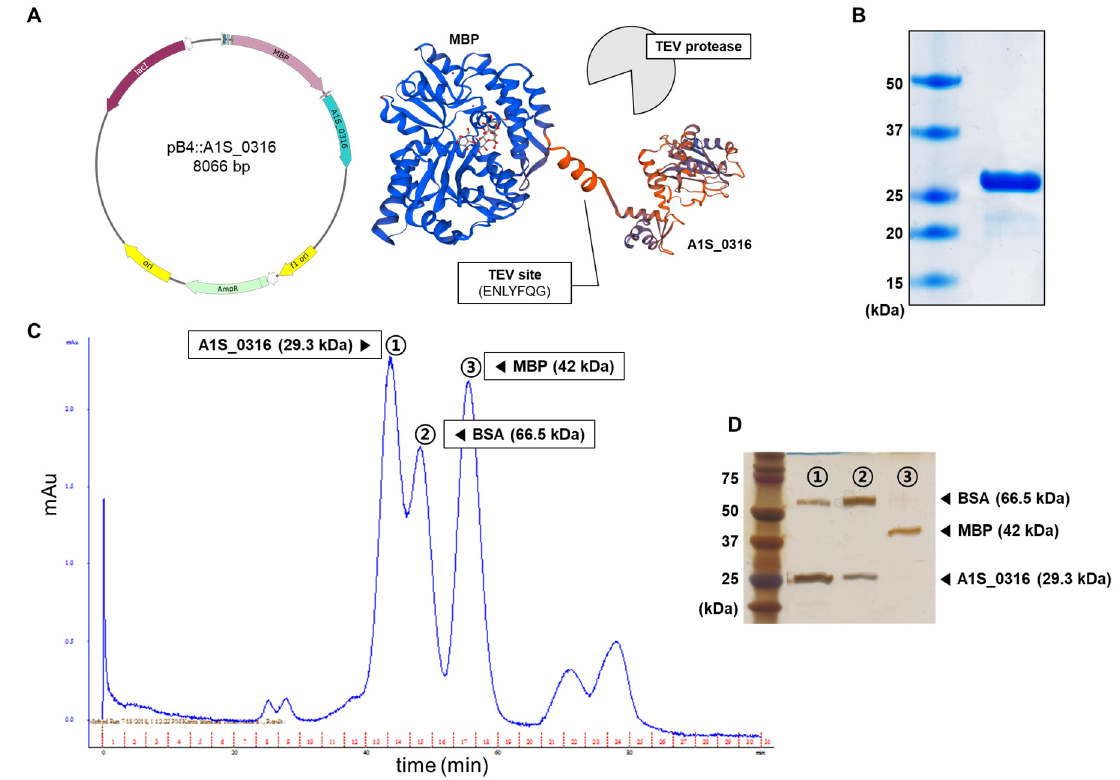
Figure 3. Characterization of the A1S_0316 protein. Overall scheme used for the purification of A1S_0316 ( A ). The purified A1S_0316 was loaded onto 15% SDS–PAGE ( B ). A1S_0316 (29.3 kDa) was compared by size-exclusion chromatography with proteins of different sizes, such as maltose-binding protein (MBP) (42 kDa) and bovine serum albumin (BSA, 66.5 kDa) ( C ). The eluents from the three kinds of high peaks were separated through 15% SDS–PAGE ( D ).